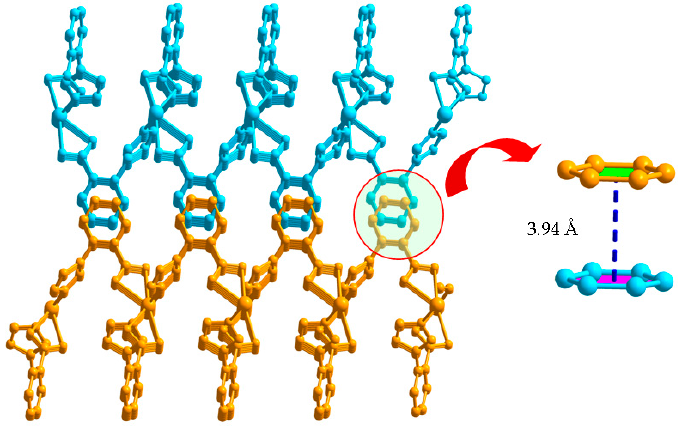
Figure 3. 3D supramolecular network structure of 1 linked by π ··· π interactions.